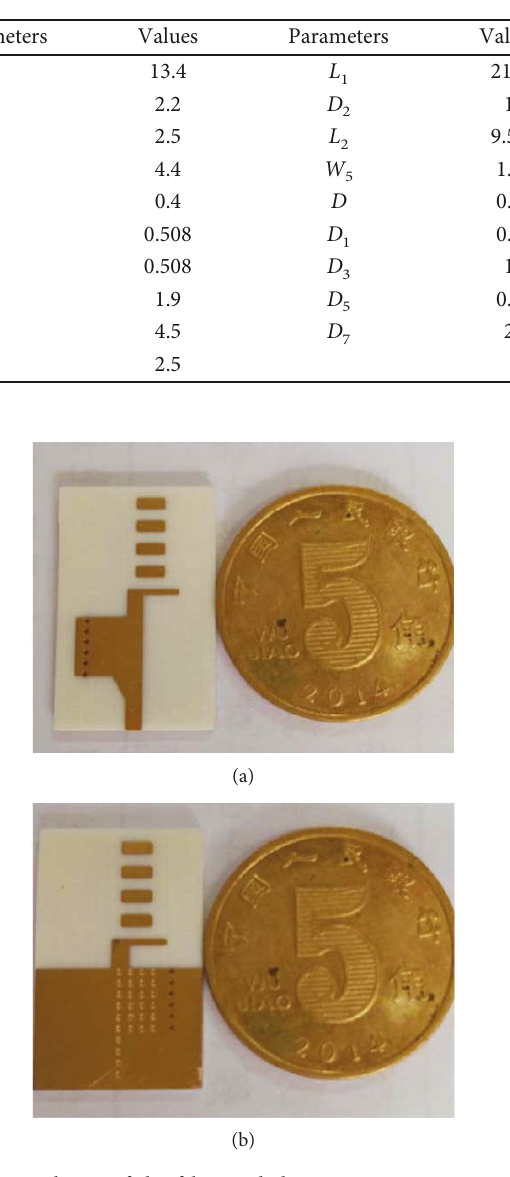
Figure 6: Photos of the fabricated slow-wave SIW Yagi antenna fabricated by Rogers 4350 substrate. (a) Top view; (b) bottom view.